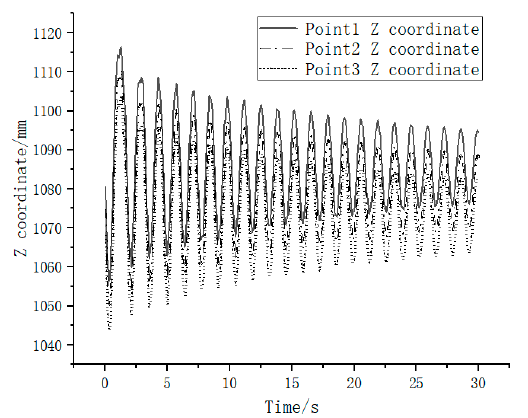
Sensors 2023 , 23 , x FOR PEER REVIEW